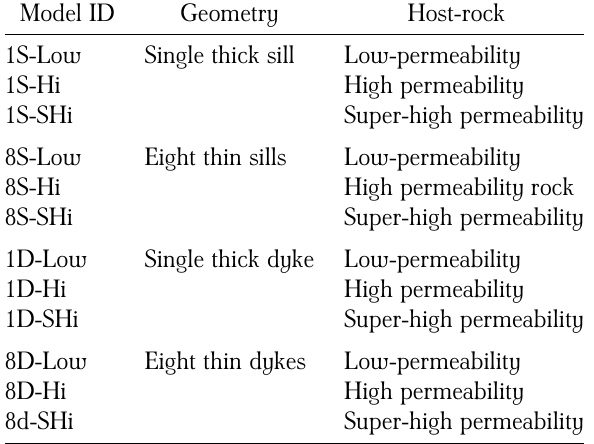
Table 3: List of the numerical models performed for this study, indicating their intrusion geometry (dyke or sill), number of in- trusions (one or eight), and the host-rock (high, low, or super- high